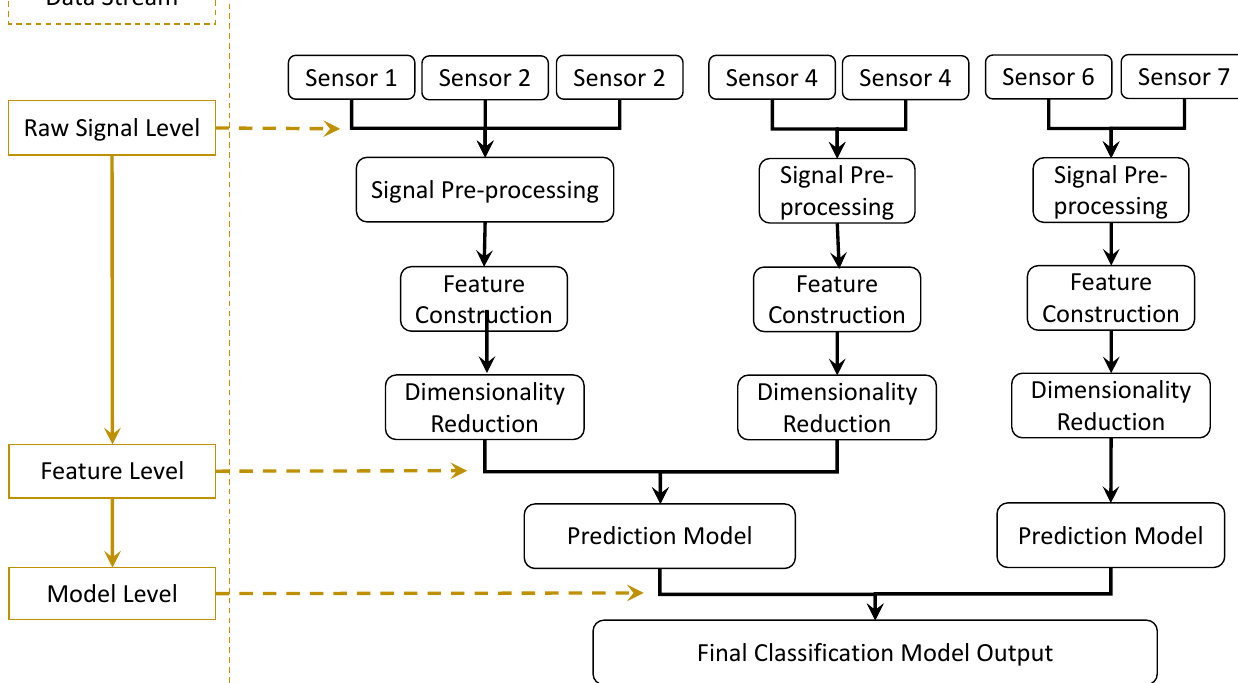
Figure 2. Arbitrary tree for data fusion levels.